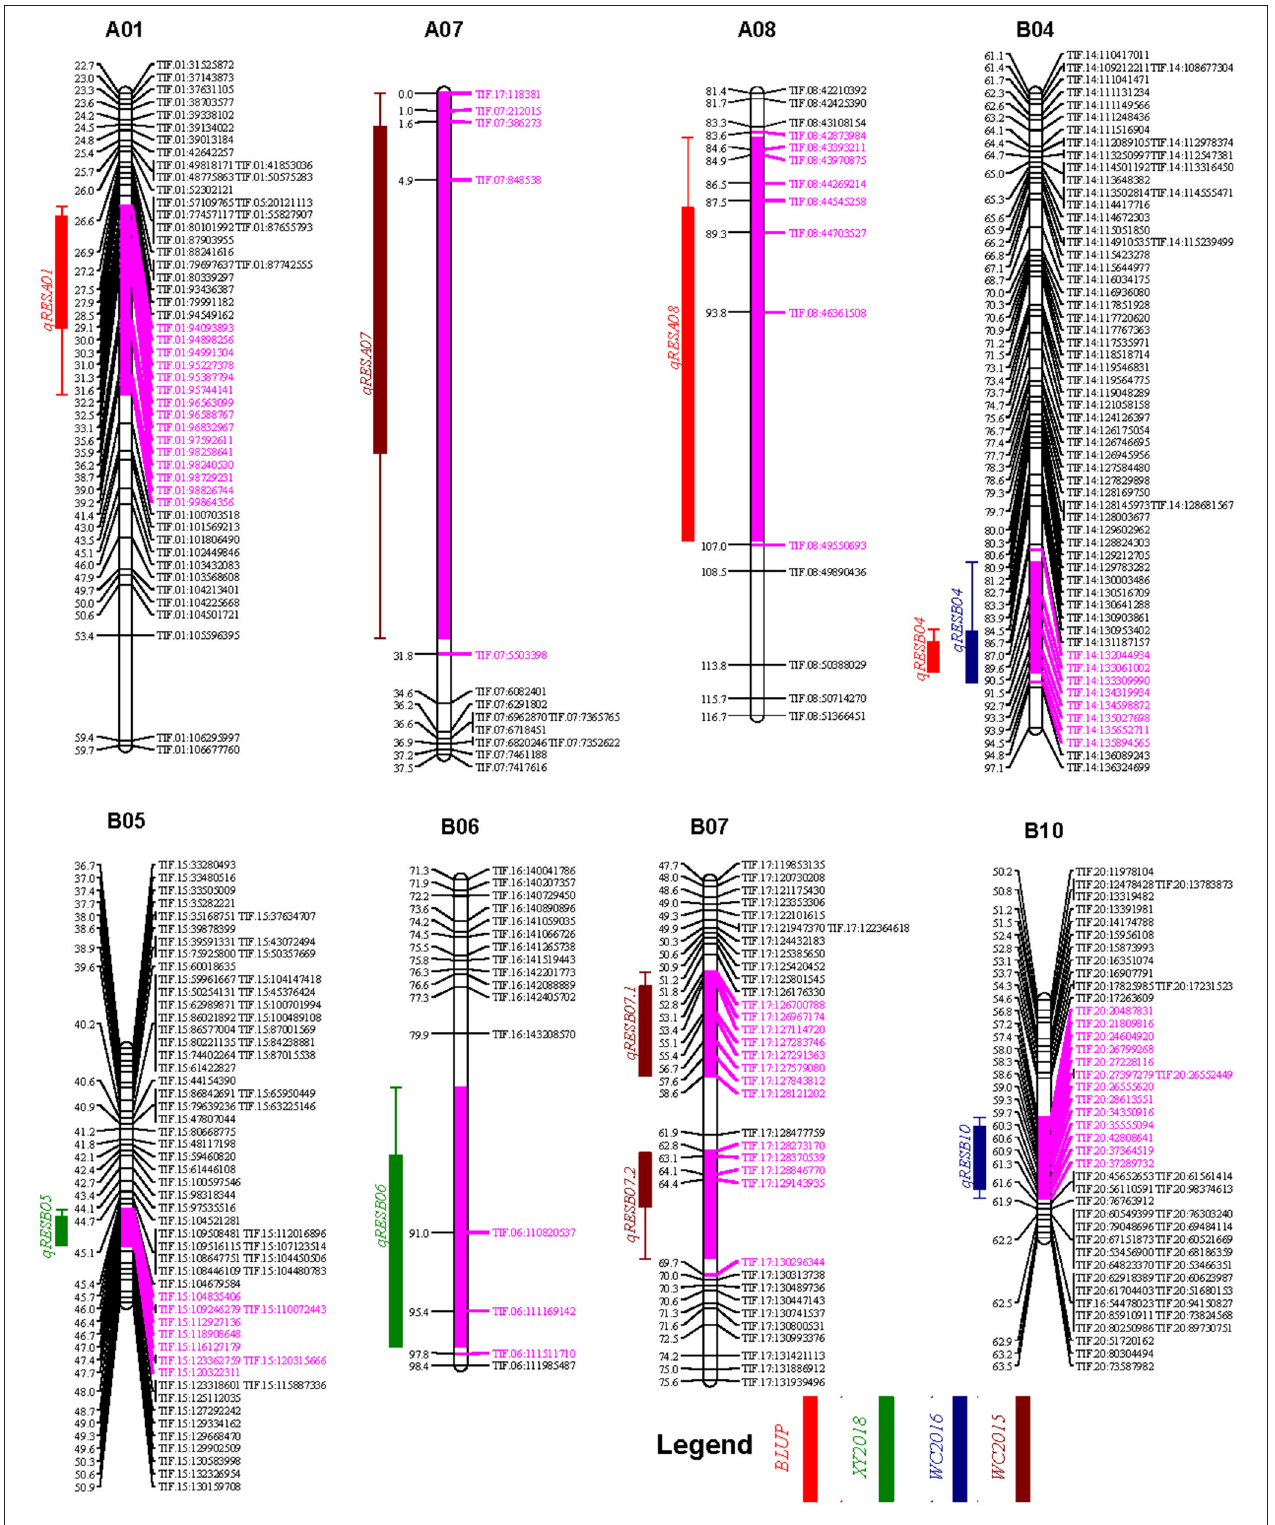
FIGURE 5 | The genetic map locations of QTL identified for resveratrol contents. QTL and their 1 LOD confidential intervals (filled boxes) and 2 LOD confidential intervals (lines) were colored according to environments as shown in figure legend. The purple color was used to highlight the 2 LOD confidential intervals on chromosome bars. Bins within the 2 LOD confidential intervals were highlighted in purple color as well.